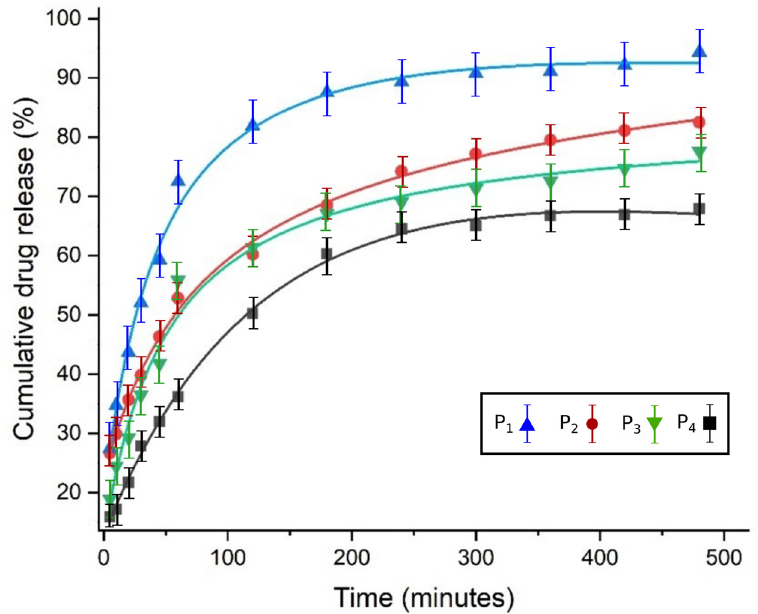
Figure 4. Cumulative % of drug release versus time.